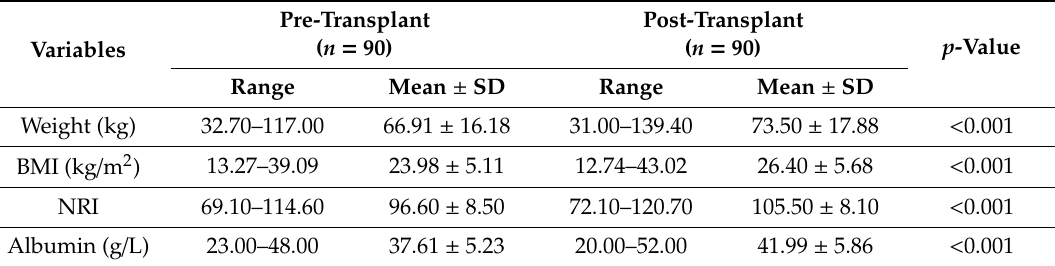
Table 2. Study variables measurements pre and